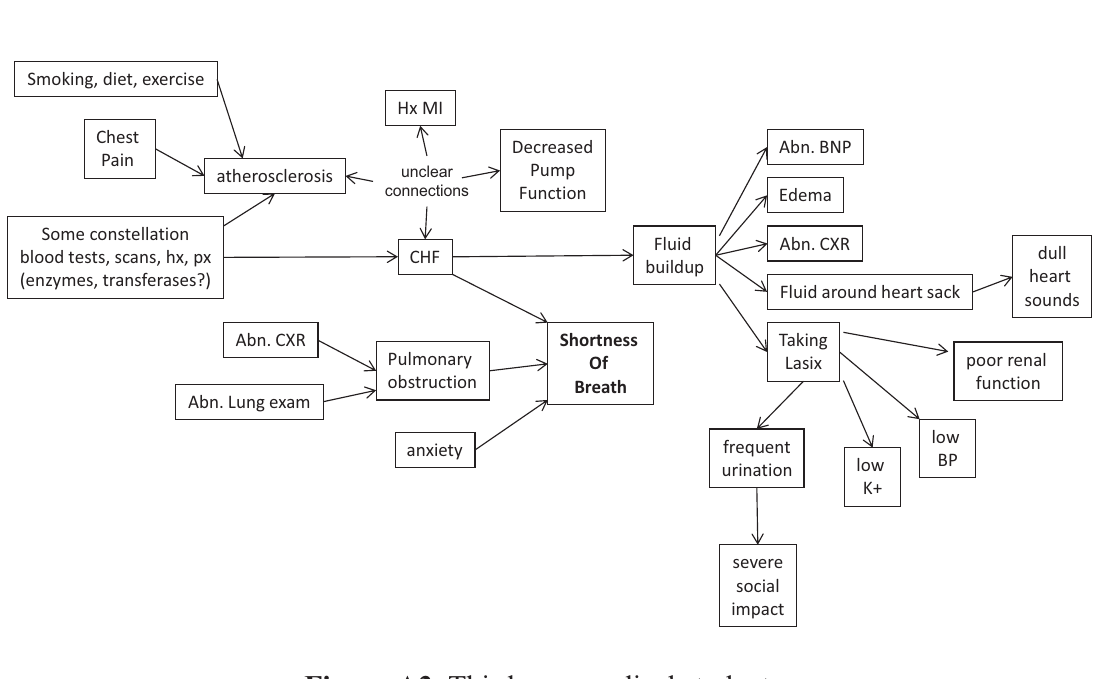
Figure A3. Third year medical